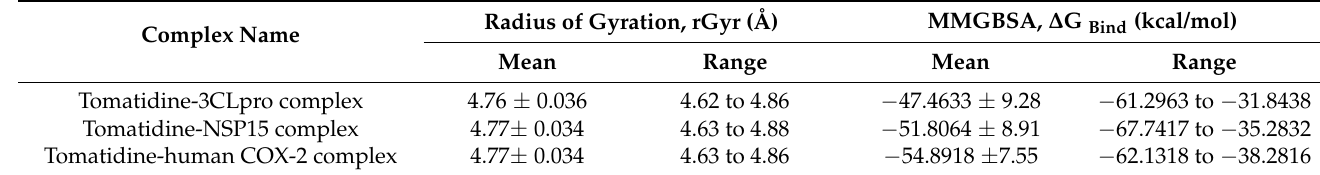
Figure 9. Radius of gyration (rGyr) graph of tomatidine in complex with SARS CoV-2 3CLpro, NSP15 and human COX-2 protein at 100 ns. Table 1. Radius of gyration of post dynamic-MMGBSA based Binding free energy ( ∆ G Bind ) for the protein ligand